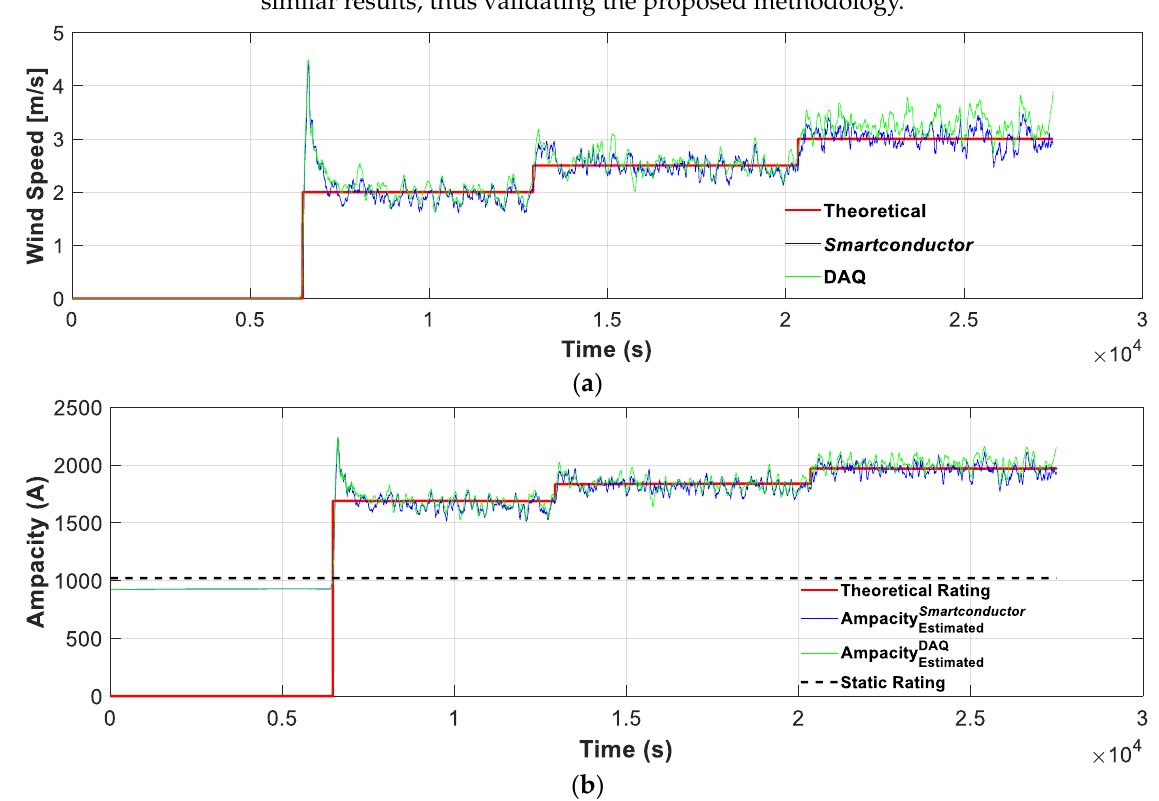
Figure 6. ( a ) Theoretical and estimated wind speeds with the Smartconductor (using the Pt1000 and Hall effect sensor) and the DAQ (using T-type thermocouple and Rogowski coil); ( b ) static and theoretical and estimated ampacity values with the Smartconductor (using the Pt1000 and Hall effect sensor) and the DAQ (using T-type thermocouple and Rogowski coil).